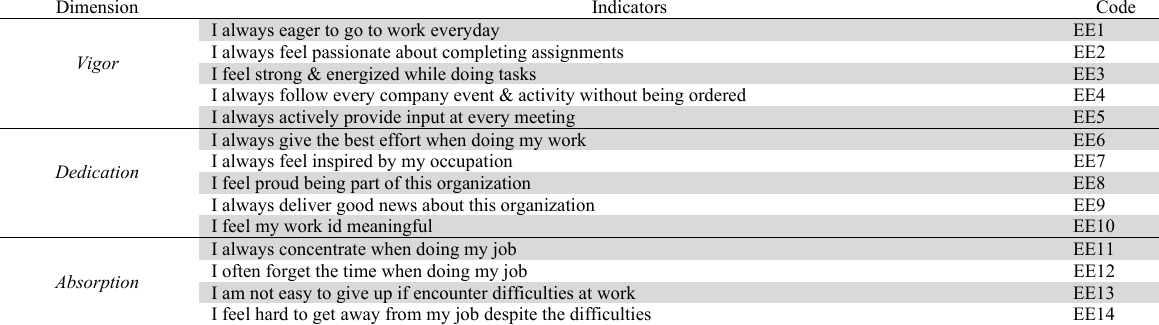
Indicators & Dimensions for Employee Engagement